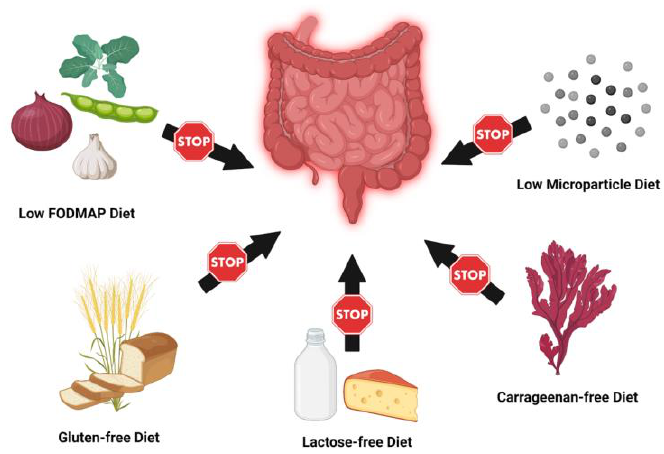
Figure 2. Elimination and Exclusion Diets in IBD